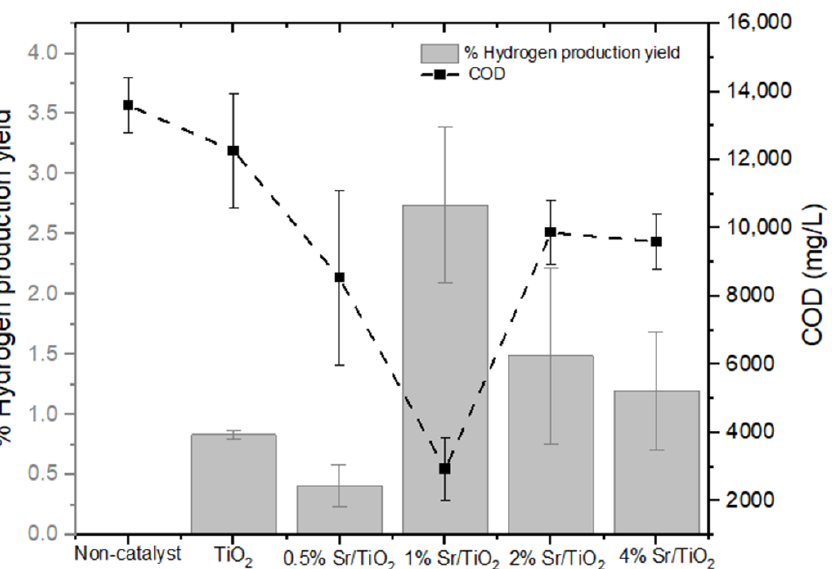
Figure 4. Hydrogen productions from synthetic urine via photocatalysis using TiO 2 and Sr-doped TiO 2 photocatalysts (at various concentrations of Sr) with COD of the urine after the photocatalytic process.